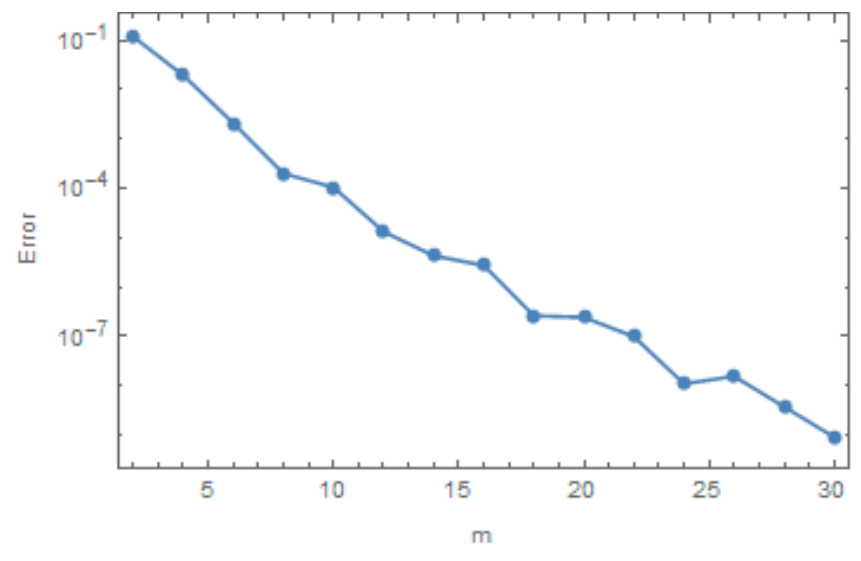
Figure 5. Residual Error.